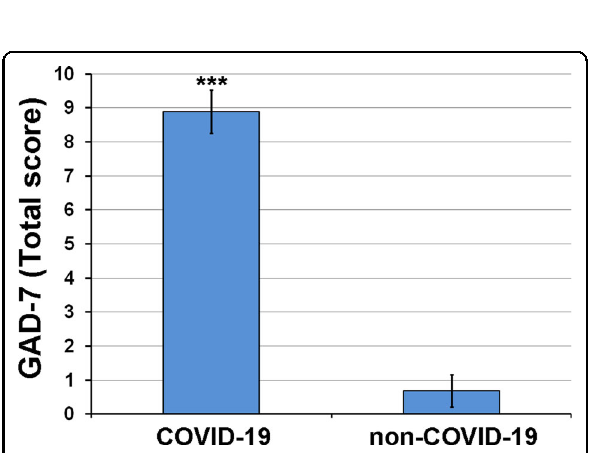
Fig. 2 COVID-19 physicians reported signi fi cantly higher anxiety scores compared with non-COVID-19 group. The Generalized Anxiety Disorder 7-Items Scale (GAD-7) in COVID-19 physician s compared with non-COVID-19 group. *** P < 0.0001 (two-sided t